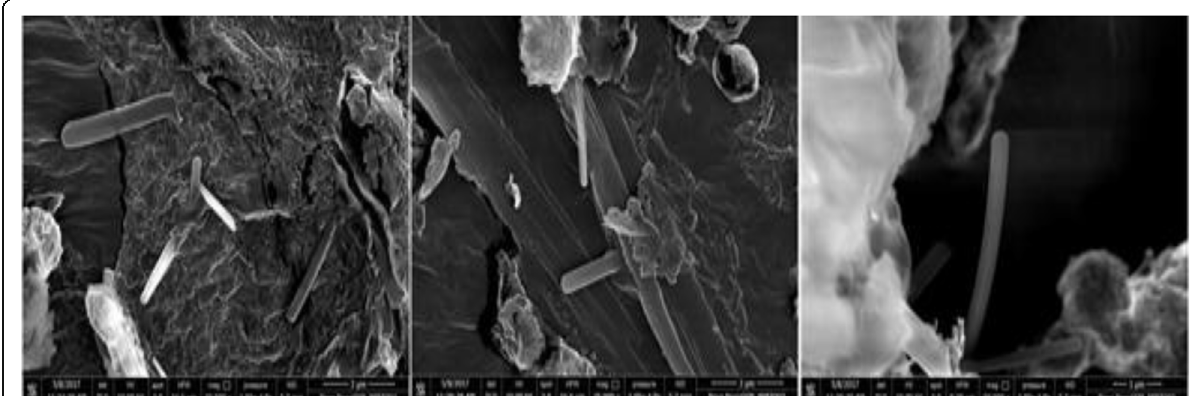
Fig. 4 Representative SEM micrographs of